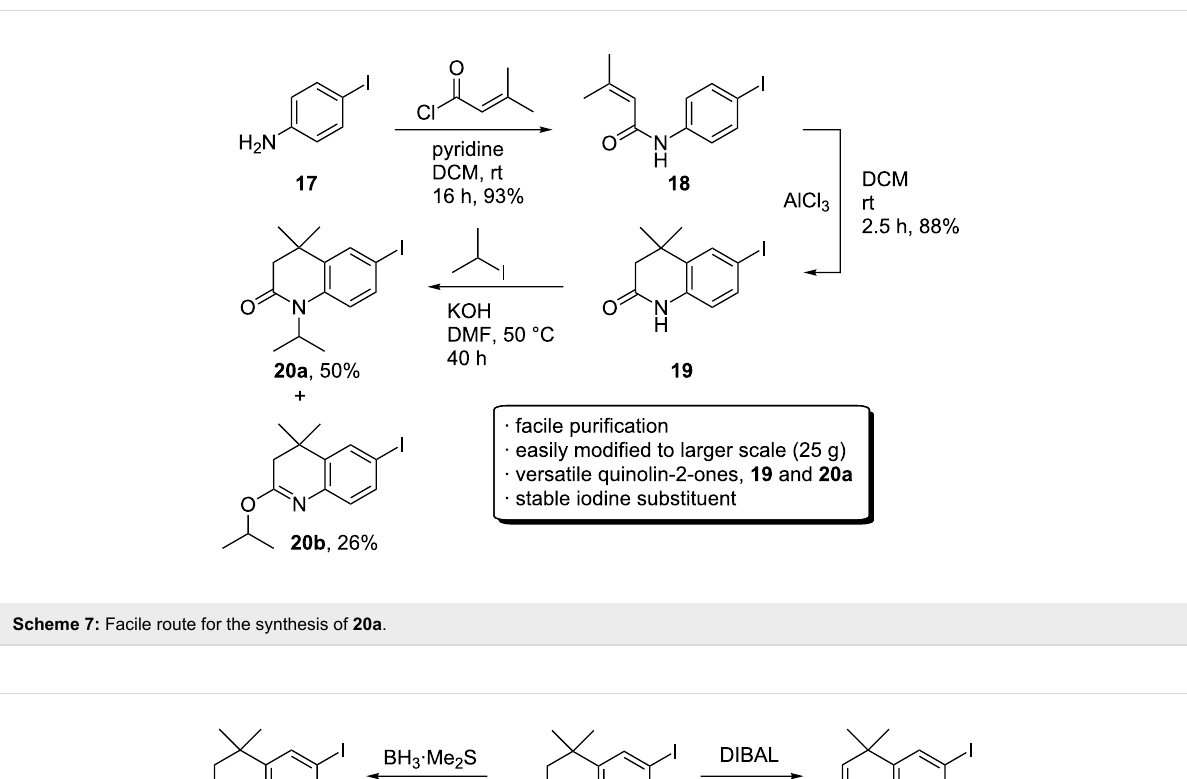
Scheme 7: Facile route for the synthesis of 20a .